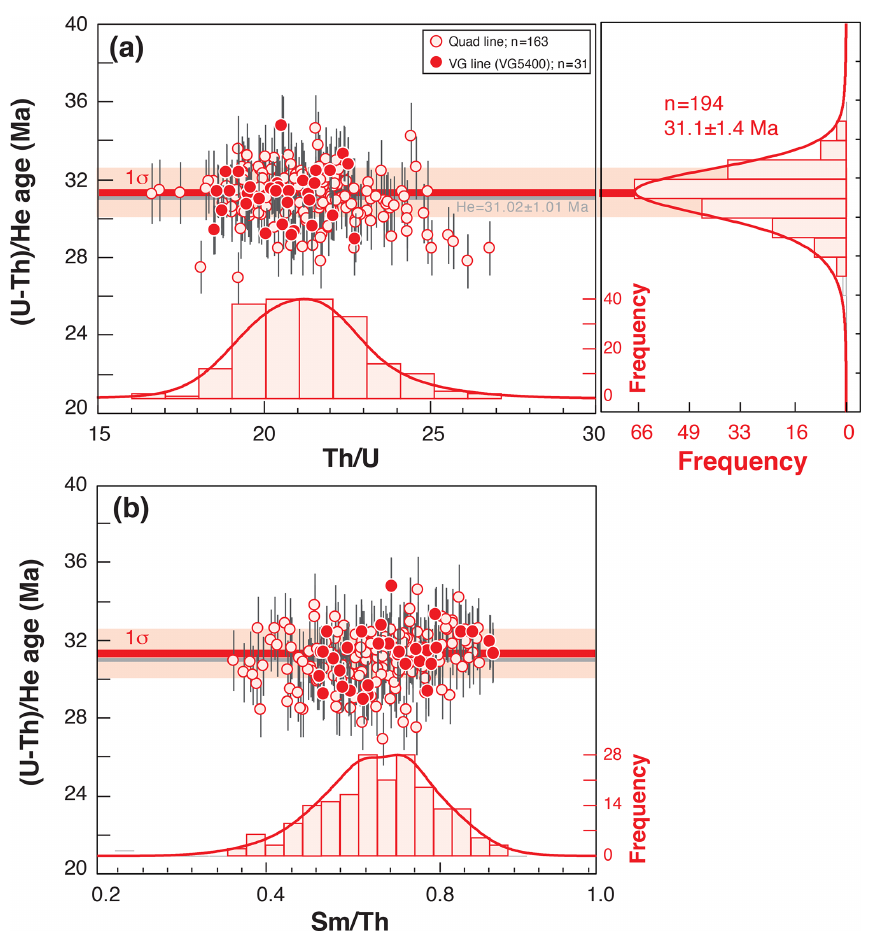
Figure 8. Durango (U–Th) / He age dispersion (1 σ shown) as a function of Th / U (a) or Sm / Th ratios (b) . Durango AHe ages and elemental ratios acquired from March to December 2019 using the quad line (open red circles) or the VG line (filled red circles). Histogram representation of the He ages; Th / U and Sm / Th ratios were constructed using RadialPlotter (Vermeesch, 2009). Th / U and Sm / Th ratios have no unit but are expressed by mass (ngng − 1